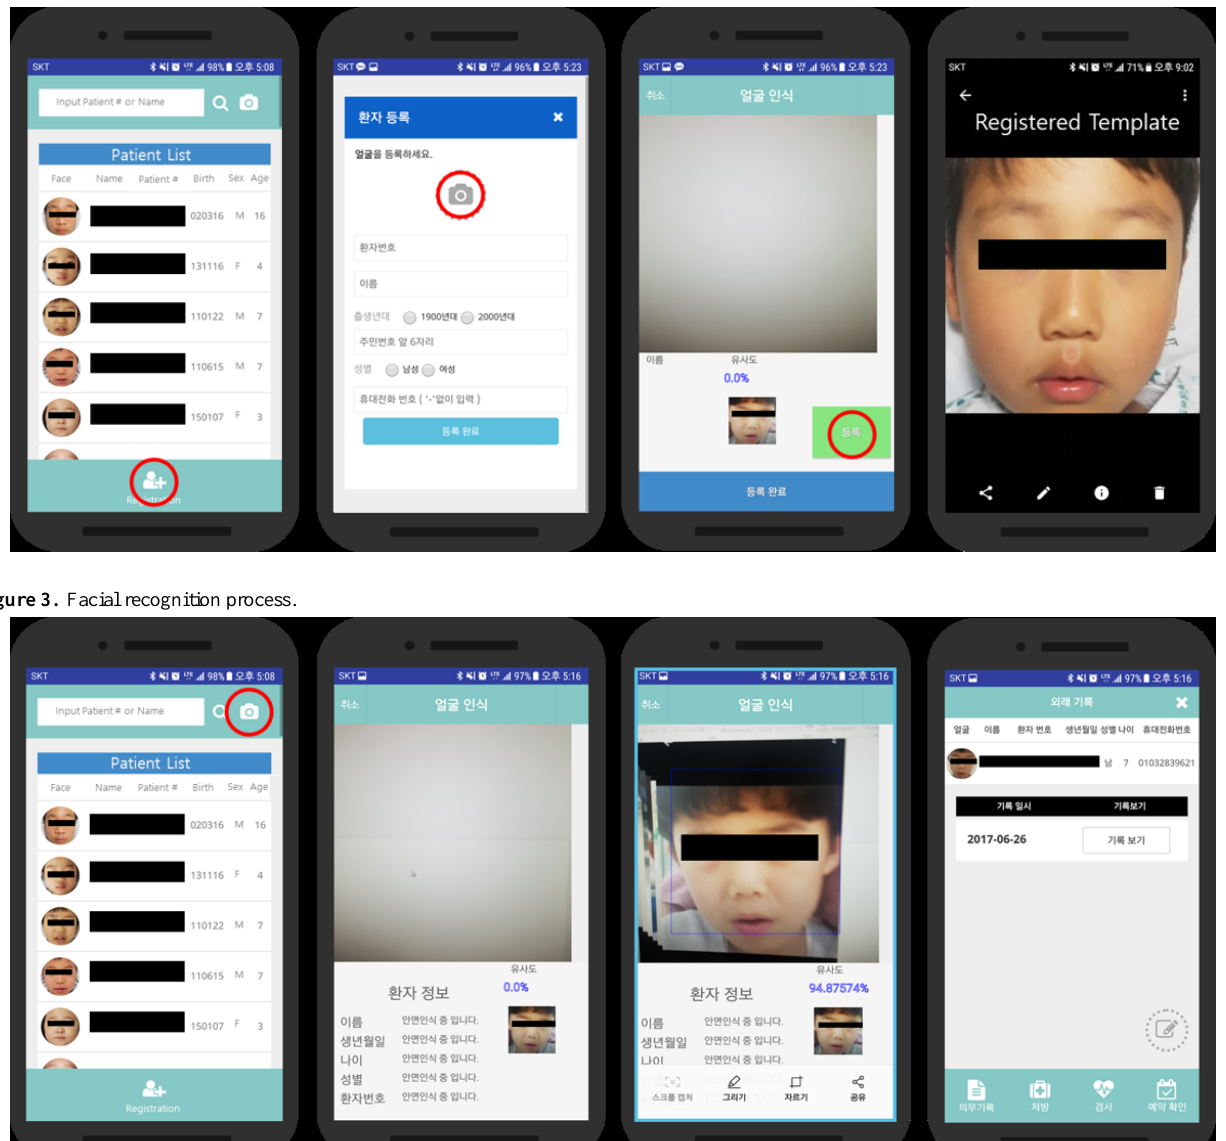
Figure 2. Registration of facial template.